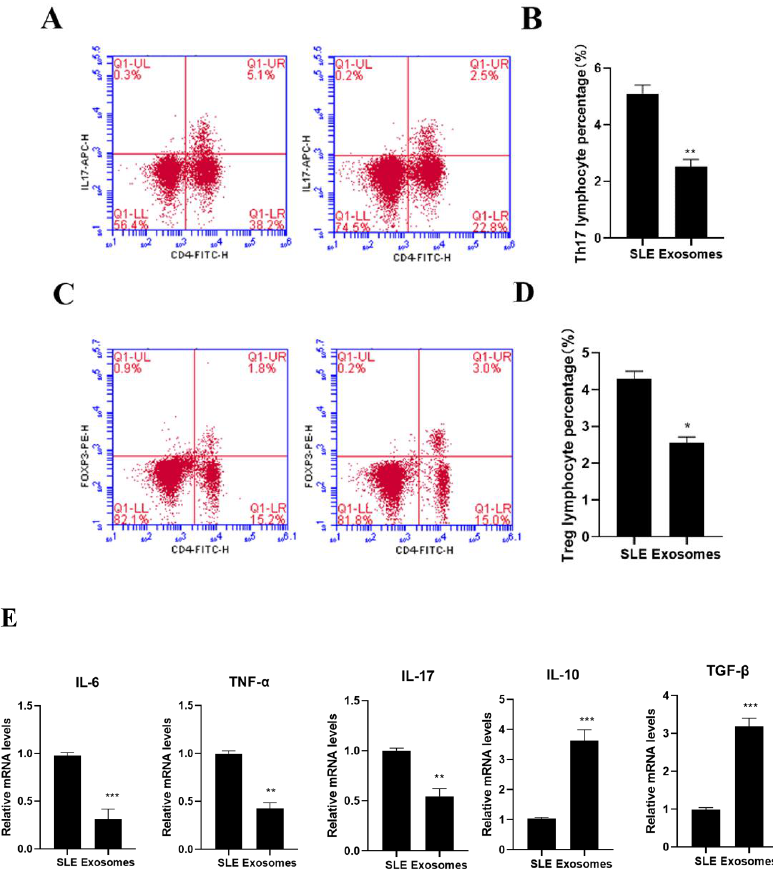
Figure 6. Impact of UC-MSC exosomes on Th17/Treg. ( A ) Flow analysis of CD4 + IL-17 + Th17 cells, ( B ) percentage of CD4 + IL-17 + Th17 cells, ( C ) flow analysis of CD4 + Foxp3 + Treg cells, ( D ) CD4 + Foxp3 + percentage of Treg cells, ( E ) PBMC production of cytokines IL-6, TNF- α , IL-17, IL-10, and TGF- β, compared with SLE group . * p < 0.05,** p < 0.01,*** p < 0.001.